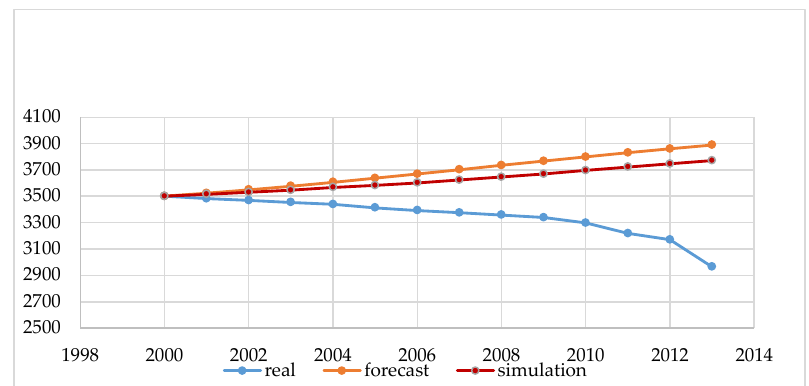
Figure 3. The demographic forecast of Lithuania (population in thousands). Source: own study based on CSO, EUROSTAT, LSD [24 – 28,36].